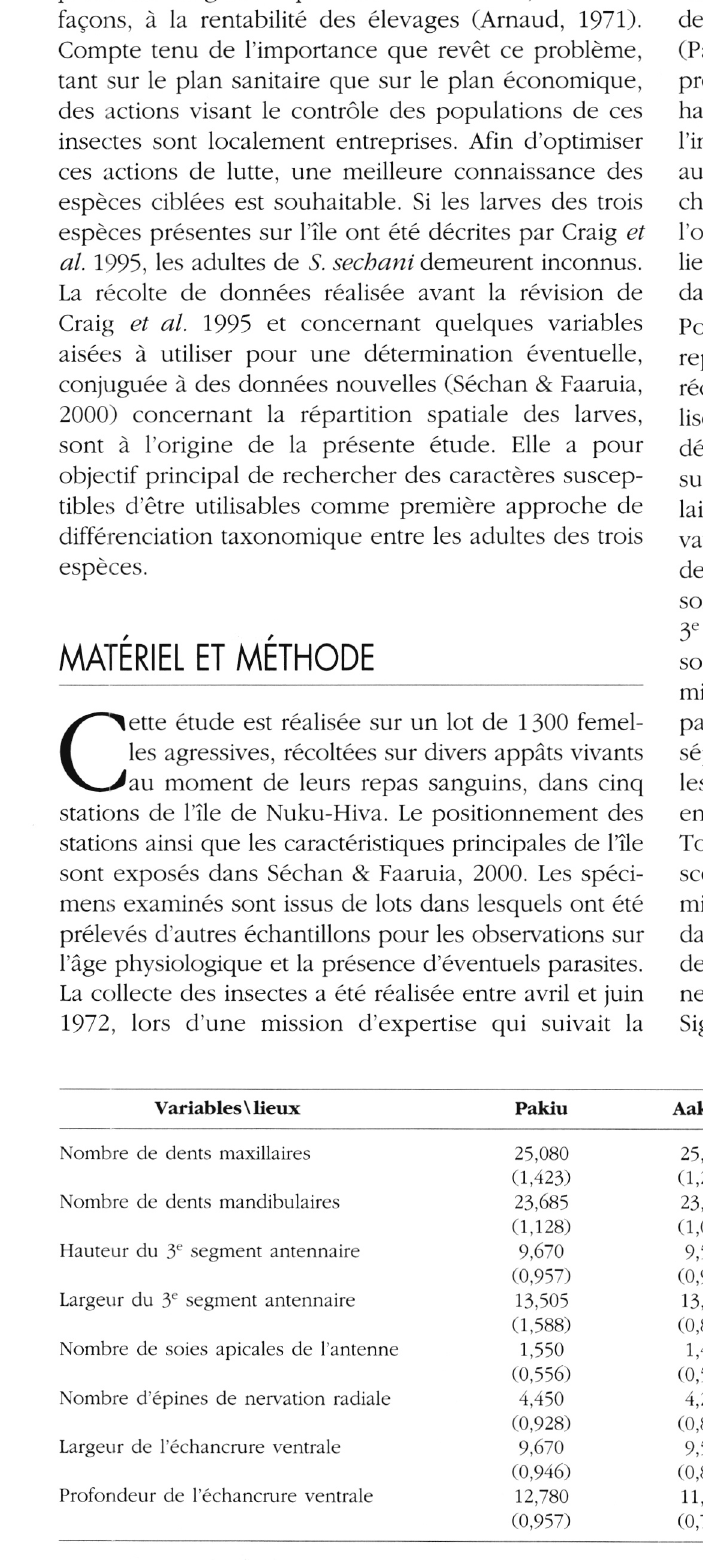
Tableau I. - Moyennes (écarts-types) des variables obtenues à partir de simulies capturées sur appât humain dans diverses vallées de l’île de Nuku-Hiva en 1972 et 1992. Les effectifs sont de 200 insectes (100 pour chaque période) par lieu de capture. Les mesures de taille